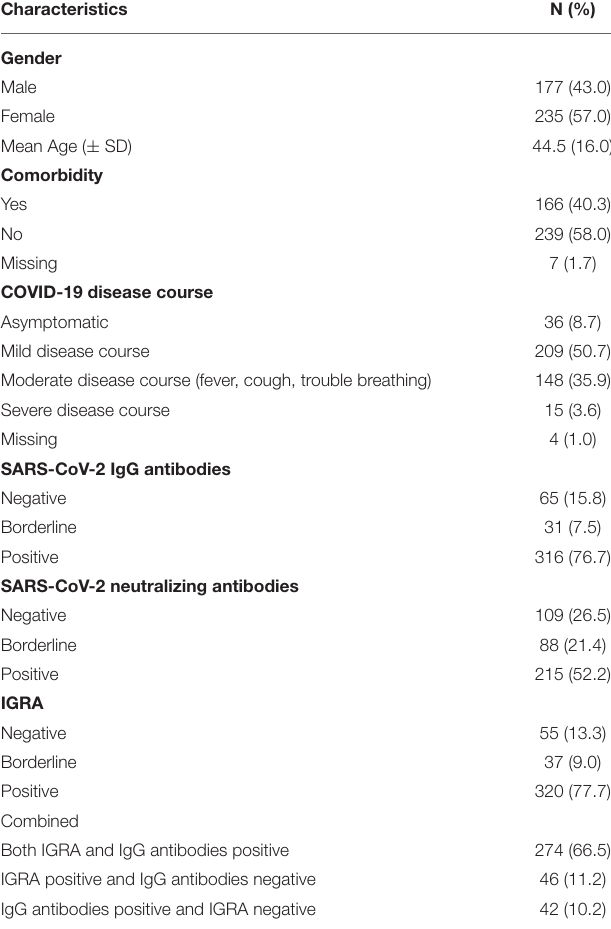
TABLE 1 | Sample characteristics ( n =